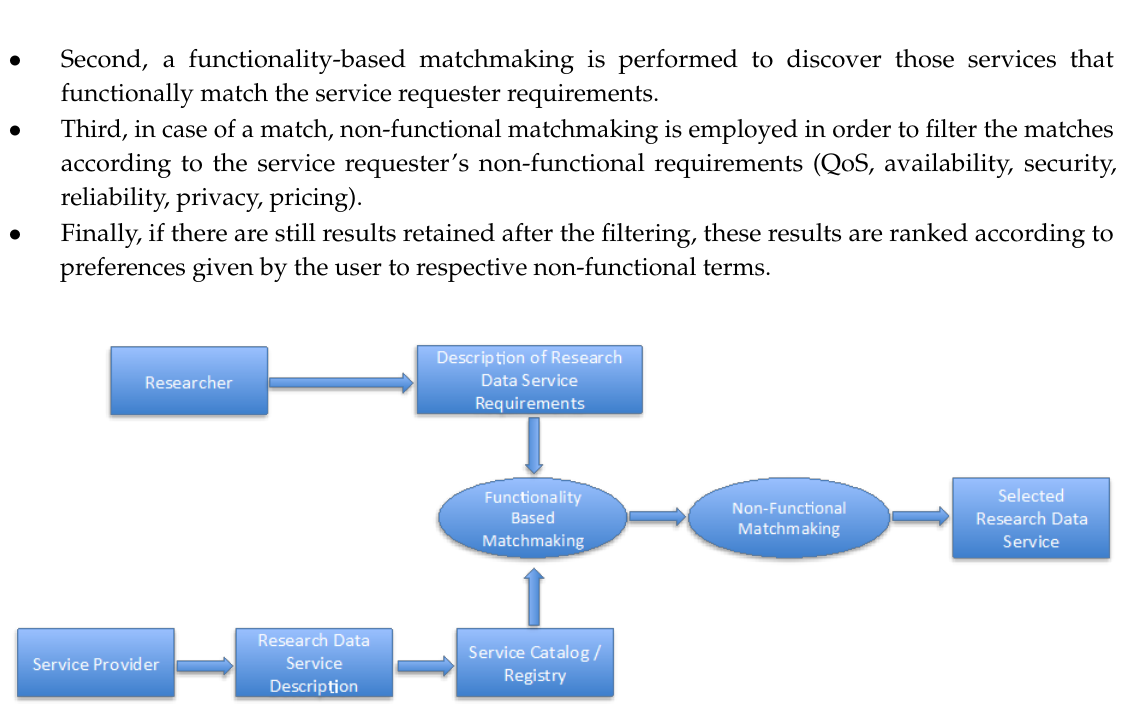
Figure 3. Research Data Service Discovery